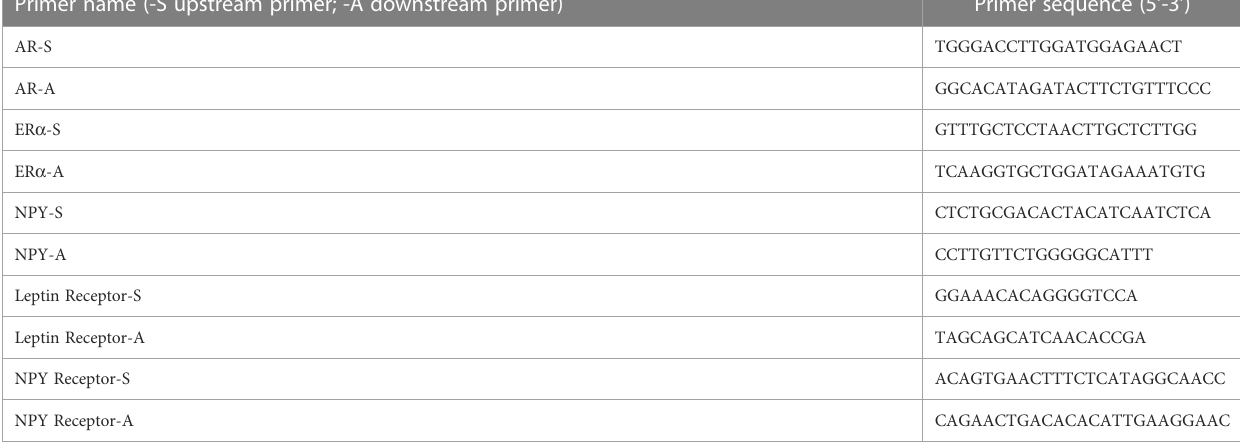
TABLE 1 PCR primer